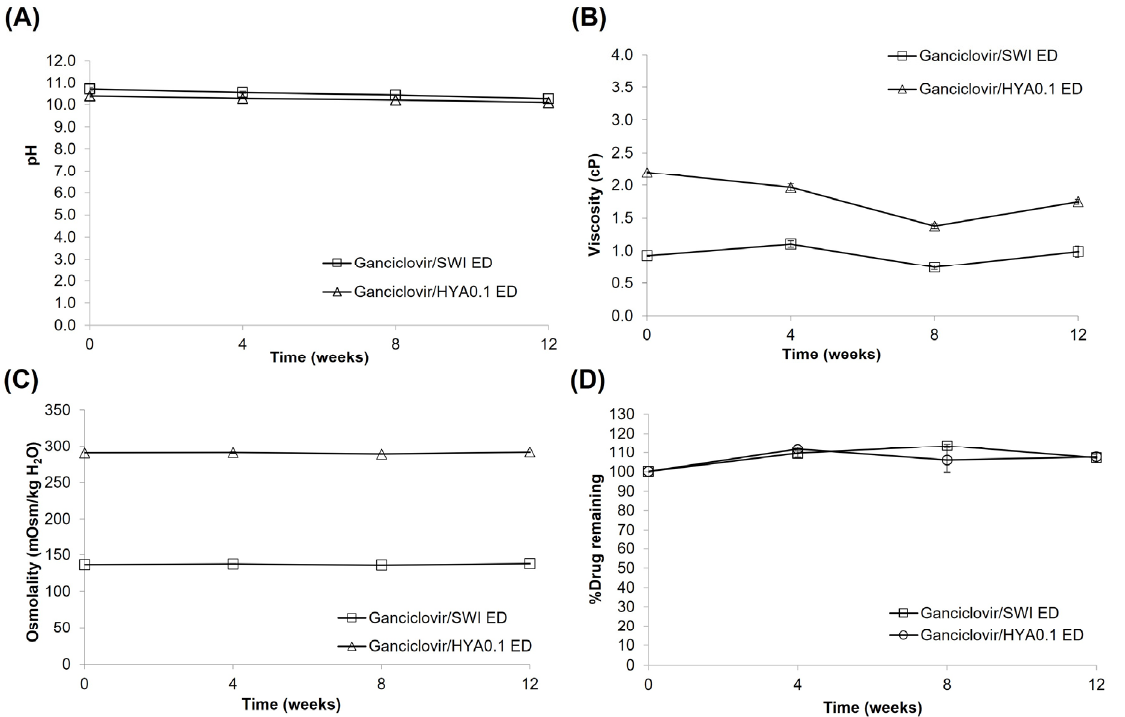
Figure 6. Stability data (pH ( A ), viscosity ( B ), osmolality ( C ), %drug remaining ( D )) of ganciclovir/HYA0.1 ED and ganciclovir/SWI ED after stored at 30 ± 2 °C for 12 weeks.